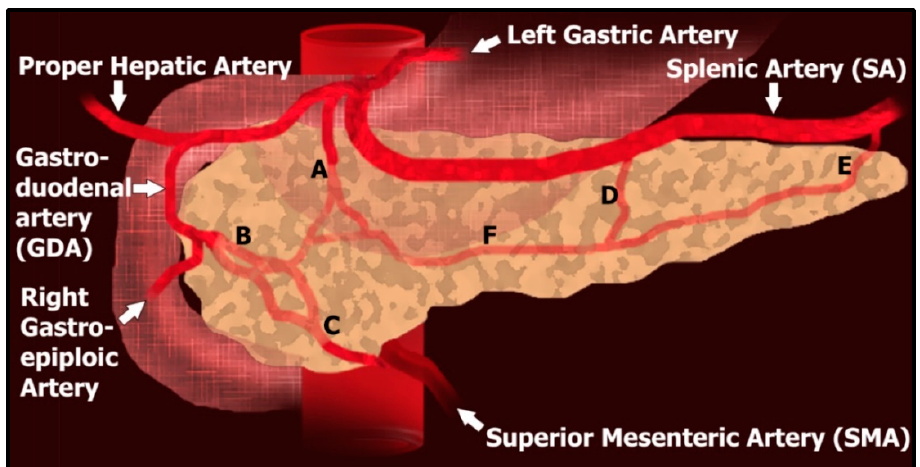
Figure 7. Normal pancreatic arterial supply. The dorsal pancreatic artery ( A ) has a highly variable origin, typically within 2 cm of the celiac trunk, and is often the largest pancreatic artery. The superior pancreaticoduodenal artery ( B ) arises from the gastroduodenal artery (GDA) and supplies the pancreatic head. The inferior pancreaticoduodenal artery ( C ) arises from the superior mesenteric artery (SMA) and supplies the uncinate process. Arising from the splenic artery (SA) is the pancreatica magna artery ( D ), which supplies the body, and more distally, the caudal pancreatic artery ( E ), which supplies the tail. The transverse pancreatic artery ( F ) travels along the body and tail, collateralizing with the other pancreatic vessels.